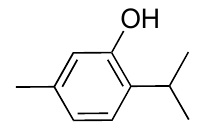
Figure 12. Thymol, a major component of essential oils from Thymus plants.